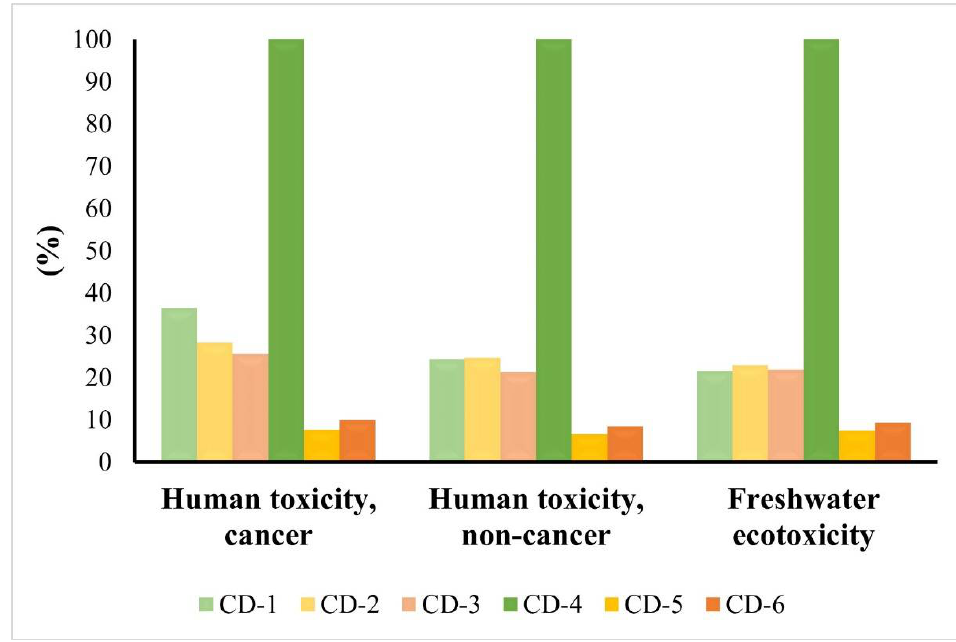
Figure 14. Relative environmental impacts of all the syntheses under study for incineration disposal scenario, applying USEtox method. Green scale refers to hydrothermal treatments; Yellow scale refers to microwave-assisted treatments; Orange scale refers to calcination treatments.